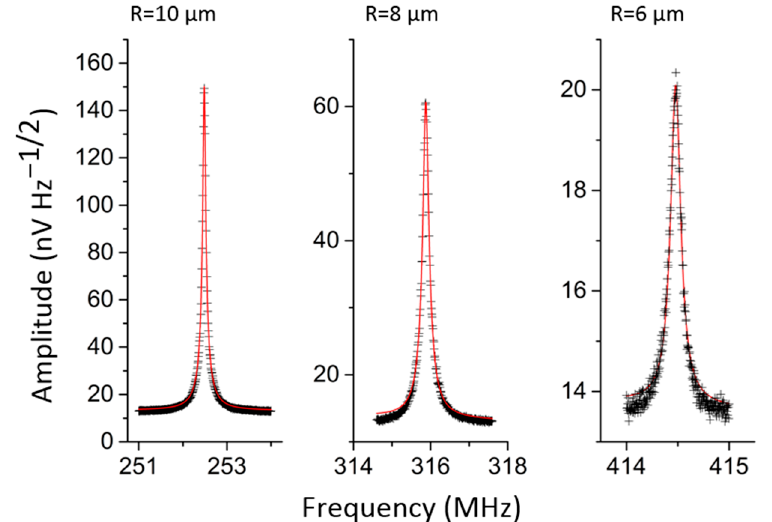
Figure 5. Thermomechanical spectra of three different disks vibrating in air. Mechanical resonances are observed at 252.5 MHz (R = 10 µm), 315.9 MHz (R = 8 µm) and 414.5 MHz (R = 6 µm) with mechanical quality factors (Q m ) of 4115, 2141 and 3778